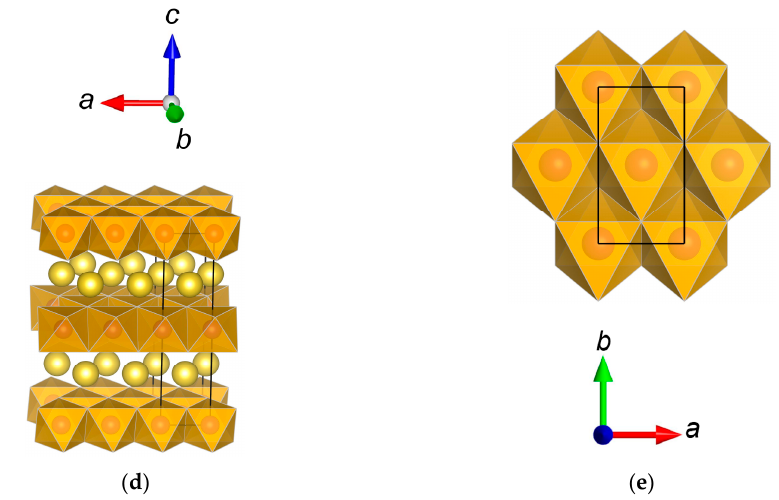
Figure 2. Scanning electron microscopy (SEM) images of ( a ) Na 0.508 Co 0.261 Mn 0.739 O 2 and ( b ) Na 0.50 MnO 2 .